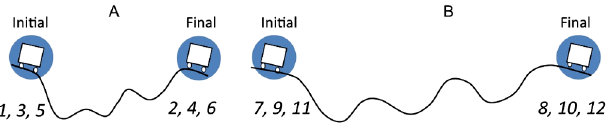
FIG. 4 (color online). Roller coaster similar problem used in the study with visual cues overlaid. The blue dots are the visual cues and the numbers in italics show the sequence of animated cues (the numbers were not seen by study